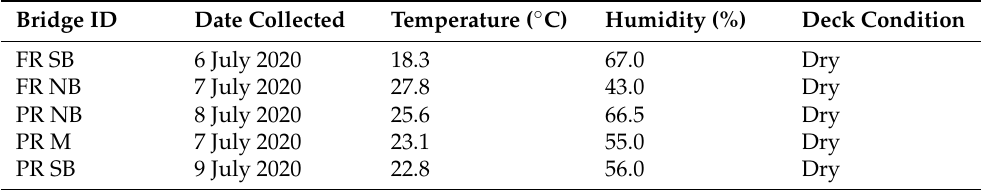
Table 5. IE and GPR data collection ambient weather and deck condition.